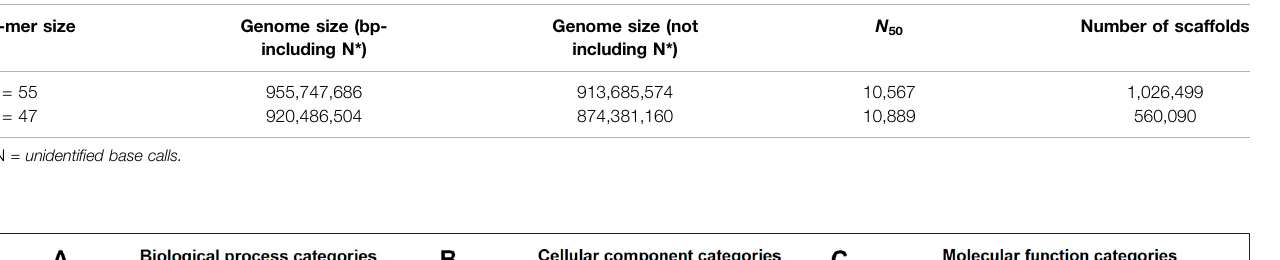
Frontiers in Genetics |